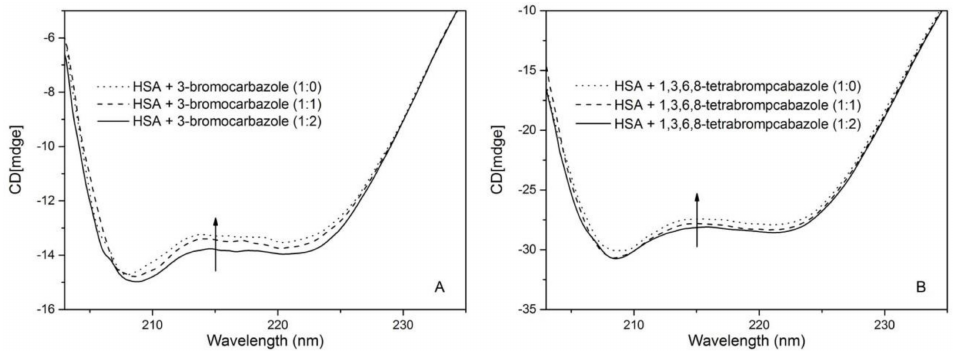
Figure 4. Absorption spectra of HSA with and without 1,3,6,8-tetrabromocarbazole or 3-bromocarbazole. ( A ): HSA-3-bromocarbazole; ( B ): HSA-1,3,6,8-tetrabromocarbazole), C HSA = 2 × 10 − 6 M;